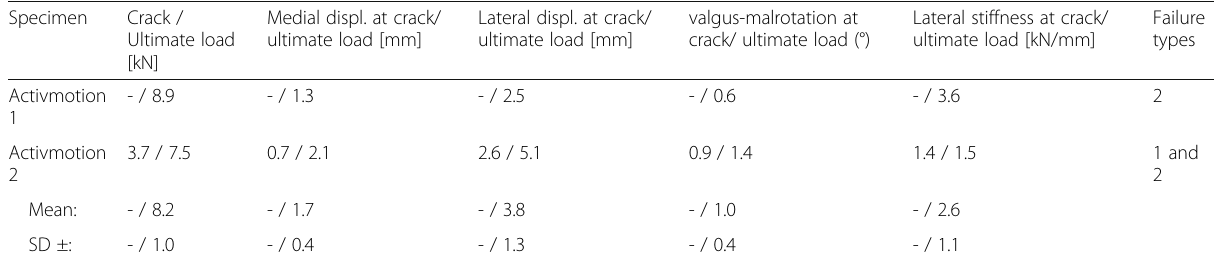
Table 4 Static tests summary: Displacements, valgus-malrotation of the tibial head and their corresponding crack and ultimate loads, including mean values and standard deviations (SD) Specimen